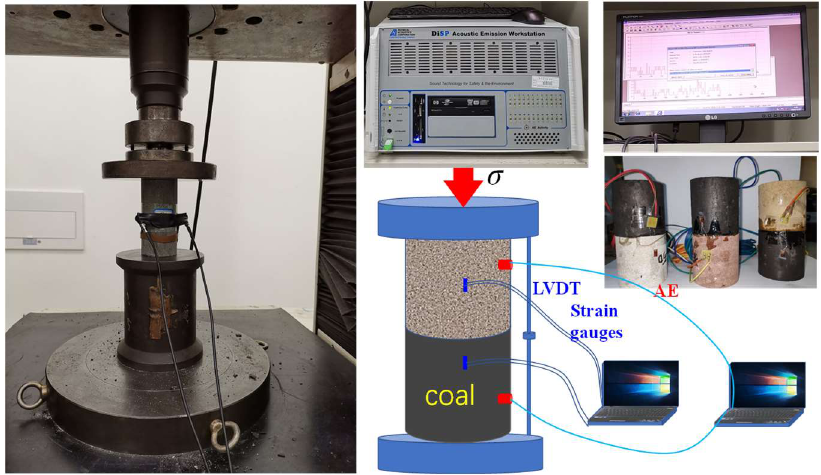
Figure 2. Principle of uniaxial mechanical testing of combined coal bodies.